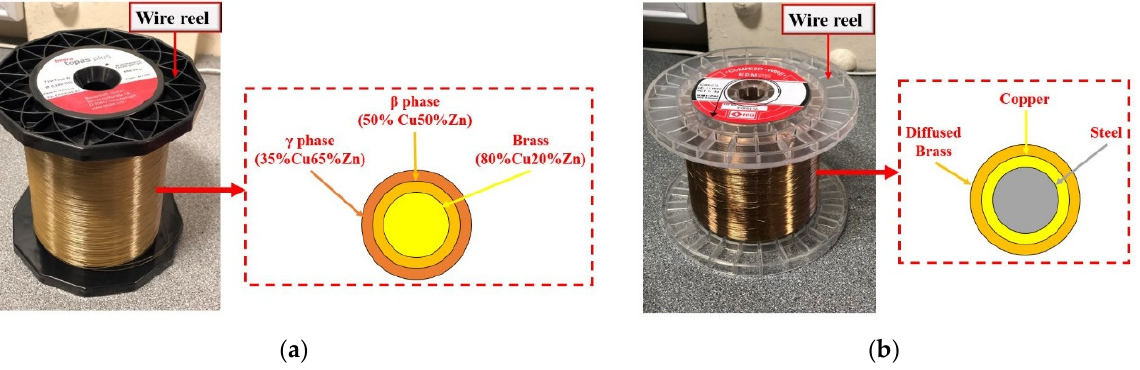
Figure 2. Composition of wire electrodes: ( a ) Topas Plus D and ( b ) Compeed.